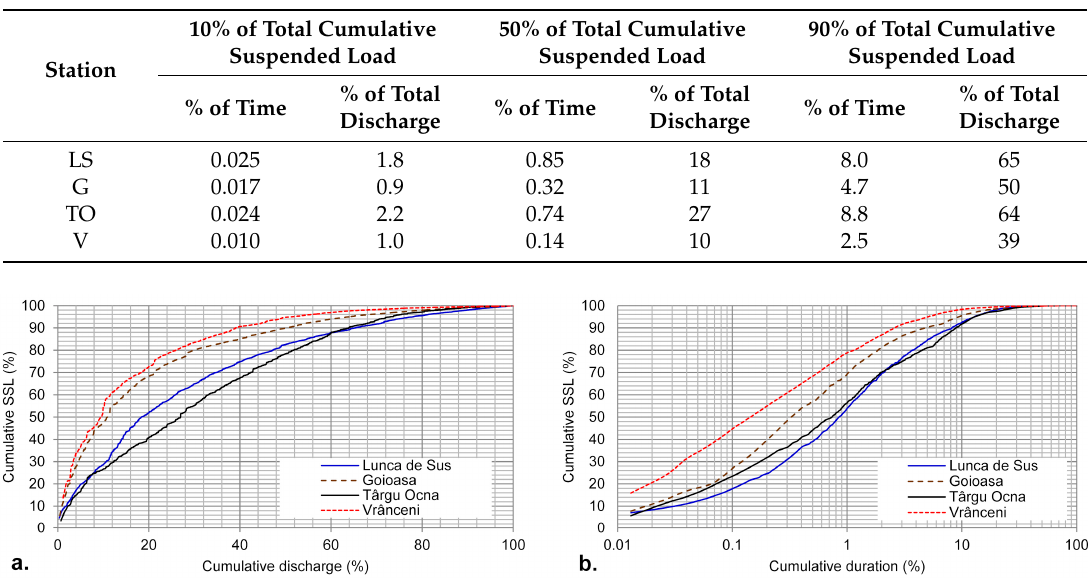
Table 6. Cumulative suspended sediment load in given percentage of time and by percentage of total discharge (period 1994–2014).